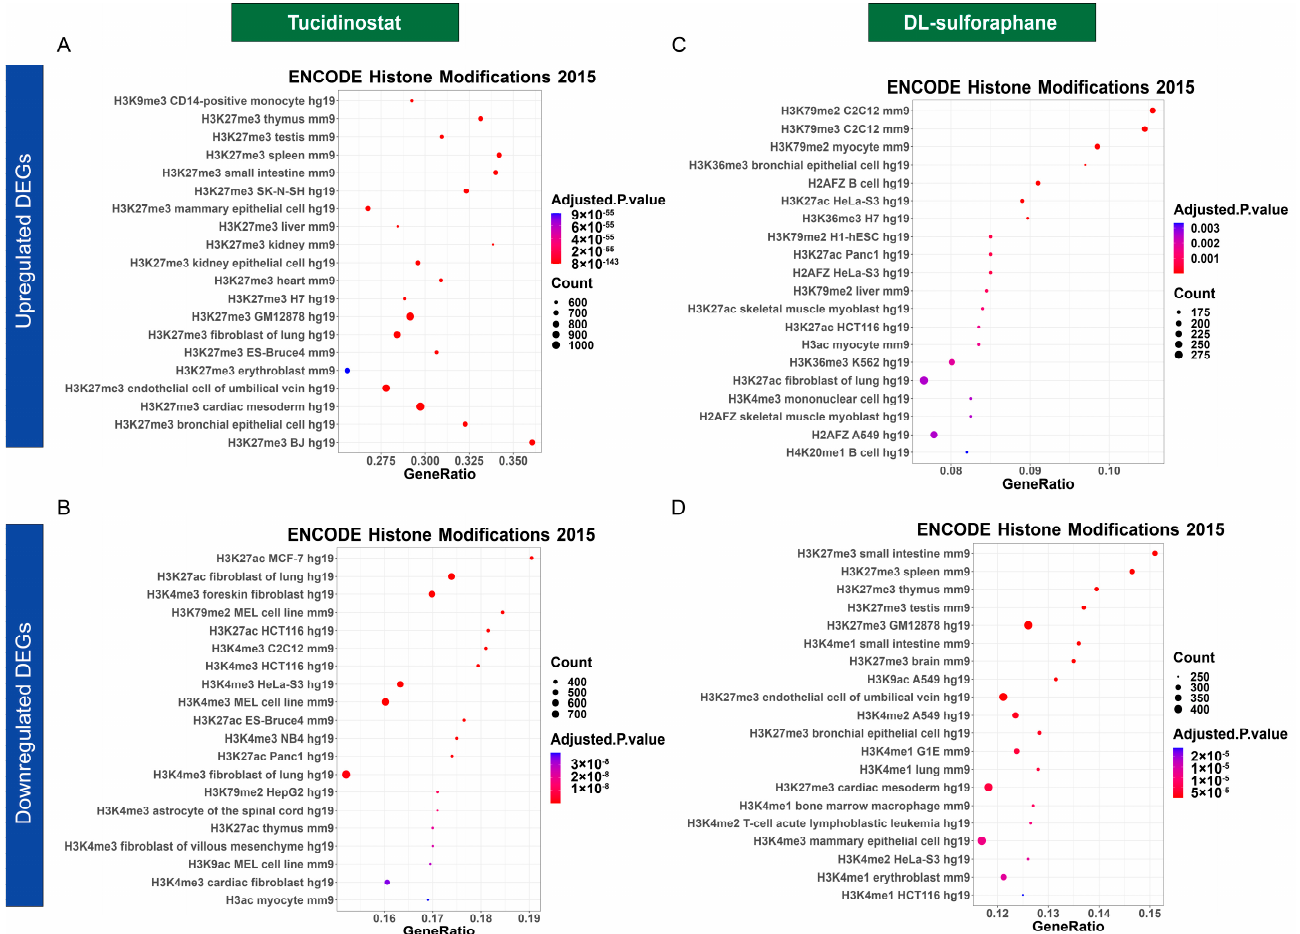
Figure 10. Dot plot analysis for histone modifications . The dot plots showed the top twenty enrichment terms for histone modification associated with up DEGs ( A ) and down DEGs ( B ) in response to Tucidinostat treatment. ( C ) histone modifications related to up DEGs in response to DL-sulforaphane treatment. ( D ) histone modifications associated with down DEGs in response to DL-sulforaphane treatment. The X -axis represents the gene ratio, and the y -axis descript the enrichment components. The area of the circle is proportional to the number of genes assigned to the term, and the color accords with the Adjusted P -value.